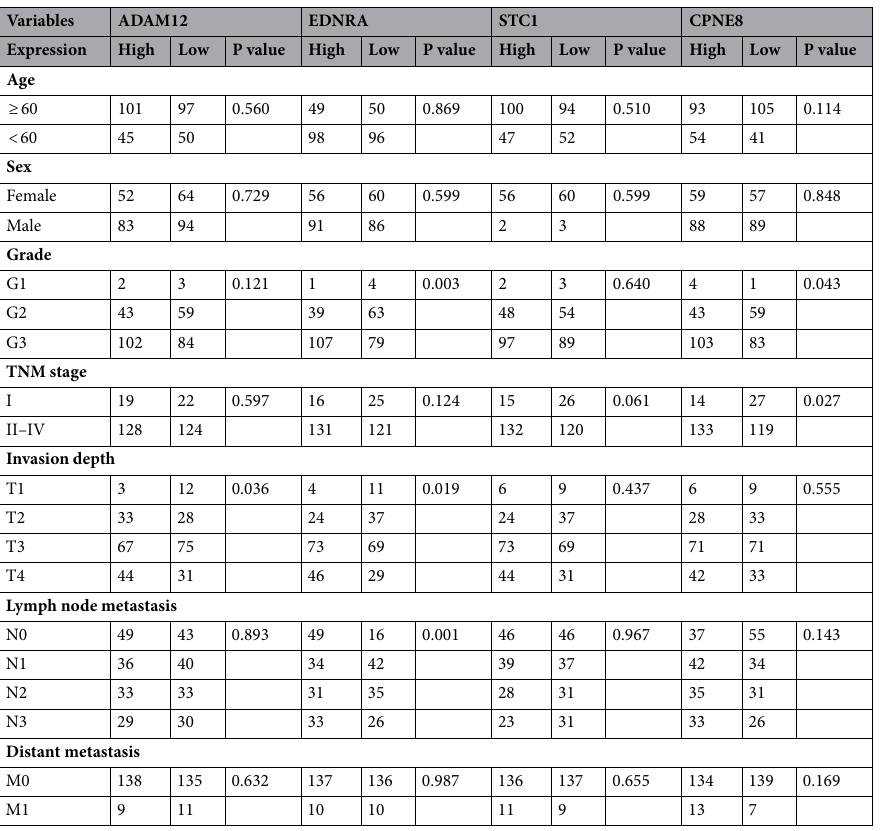
Table 1. Relationship between miR-30c-5p target gene expression and clinicopathological features in